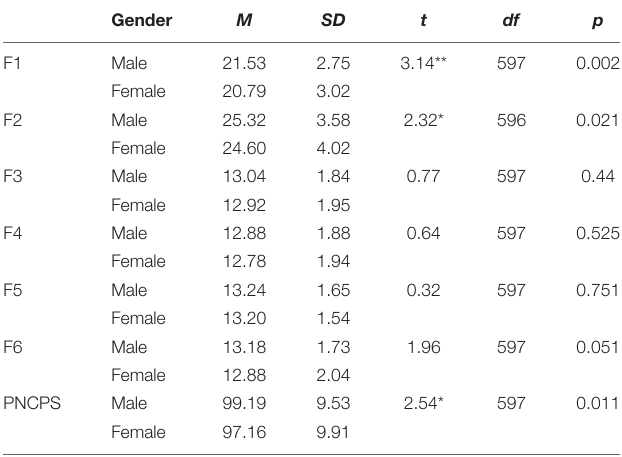
TABLE 4 | Influence of gender on